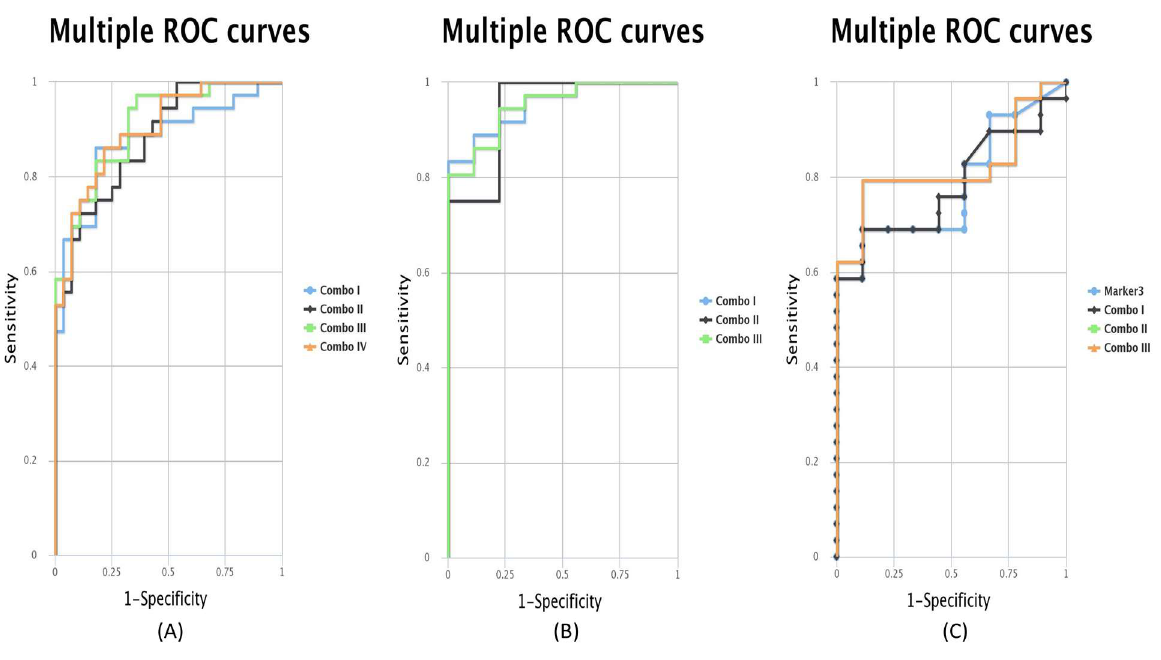
Figure 7. ROC curves for combinations of targets for ( A ) normal vs. CIN samples, ( B ) normal vs. cancer samples, and ( C ) CIN vs. cancer samples.